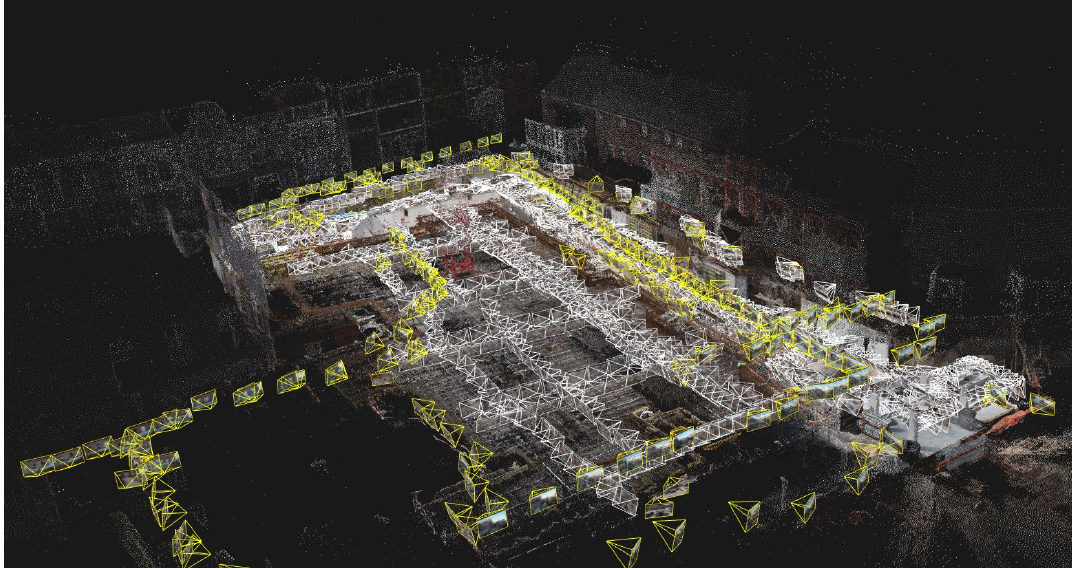
Figure 1. In the proposed method the alignment of recorded site images (white) is aided by the pre-registered accurate reference module